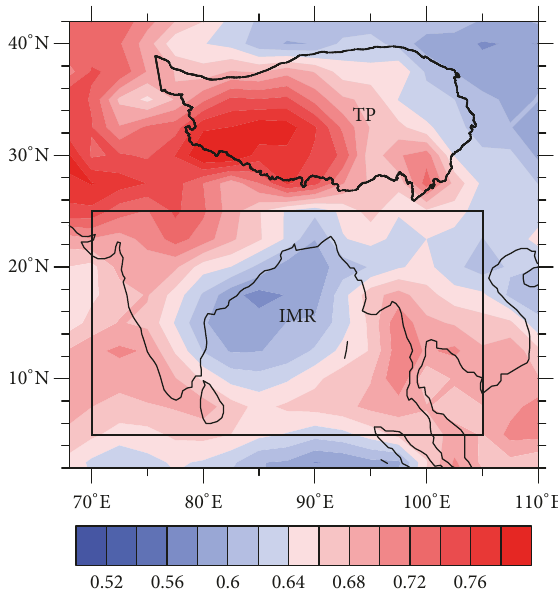
Figure 4: The geographical distribution of the scaling exponents of the daily OLR sequence over TP and IMR.